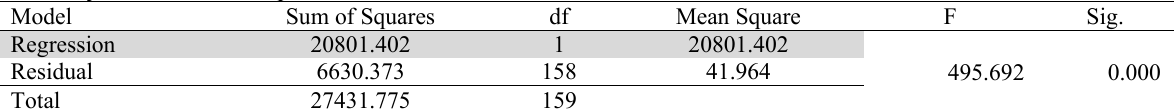
ANOVA job satisfaction and performance